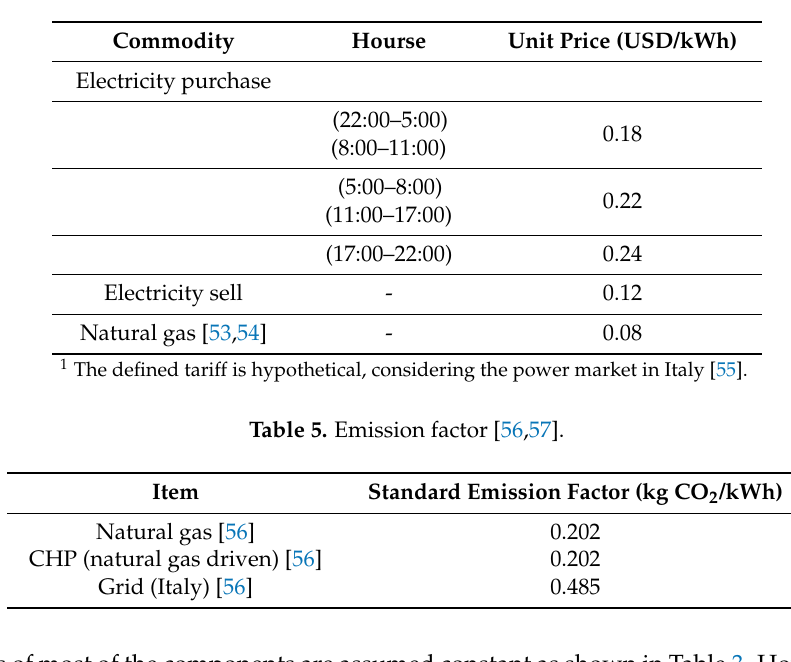
Table 2. Technical specification of each component.